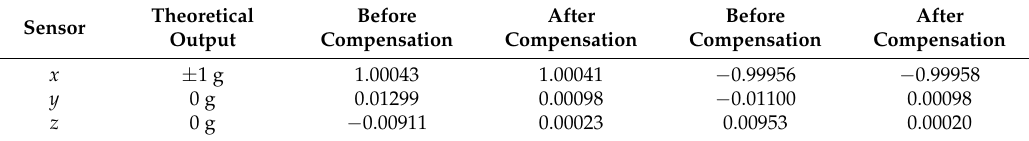
Figure 6. Velocity and position before compensation: ( a ) velocity; ( b ) position.